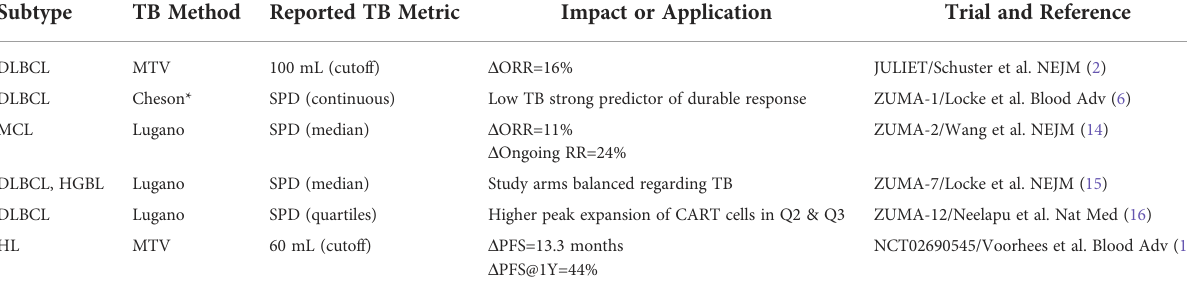
TABLE 2 Reported Tumor Burden Metrics in Recently Published CART Trials.